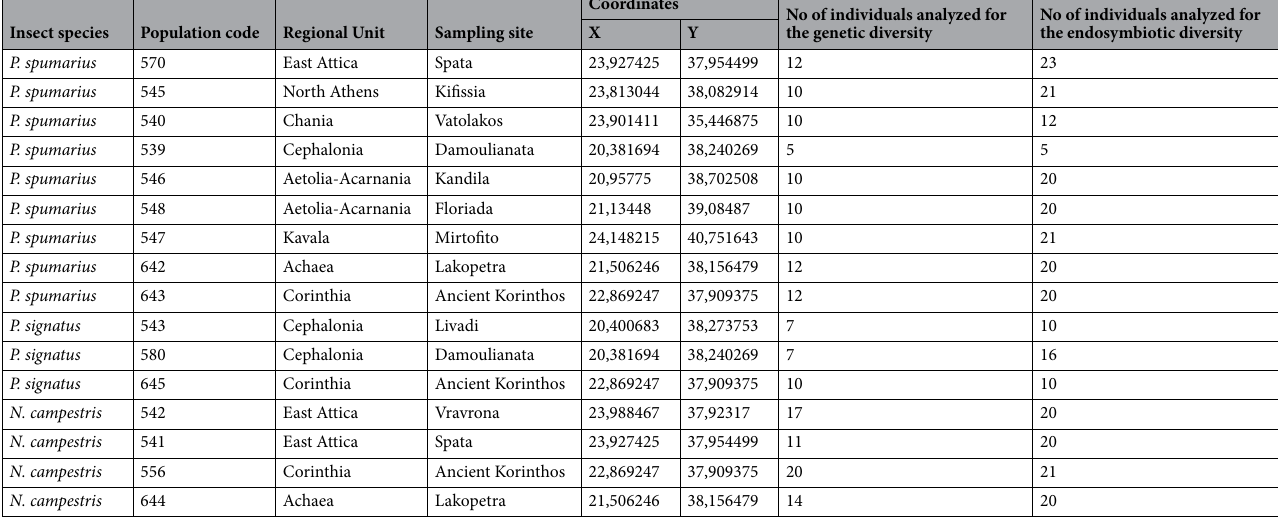
Table 3. Population codes of Philaenus spumarius , P. signatus and Neophilaenus campestris used for the analysis, including collection sites and total number of individuals from each population used for the genetic and endosymbiotic